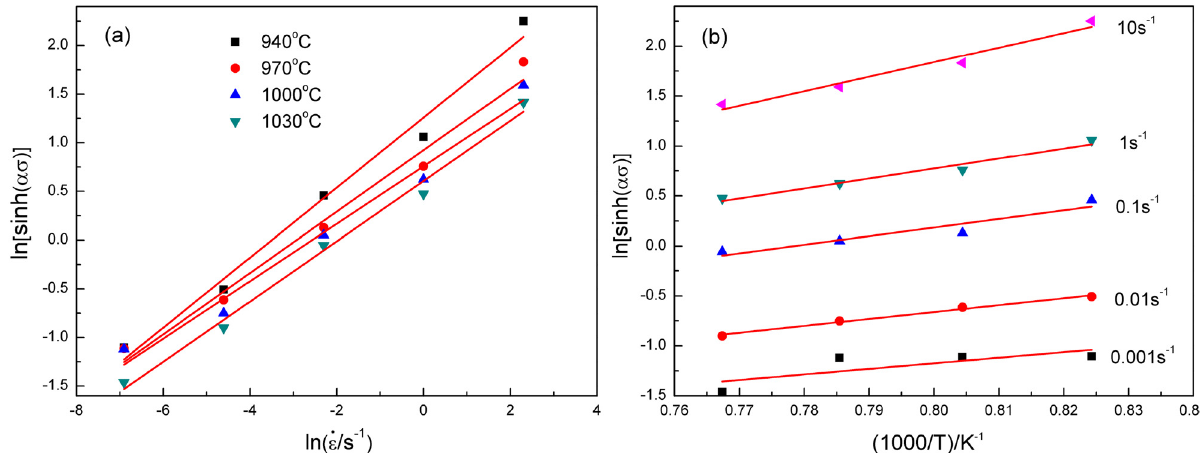
Figure 4: Linear regression analysis of ( a ) ln [ sinh ( ασ )] − ln ε ̇ and ( b ) ln [ sinh ( ασ )] − 1,000/ T